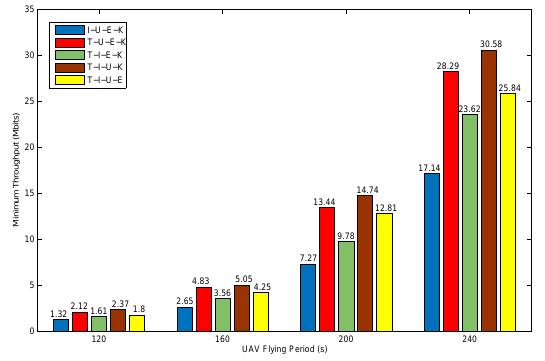
Figure 11. Performance comparison of different optimization target when B k [ 0 ] >